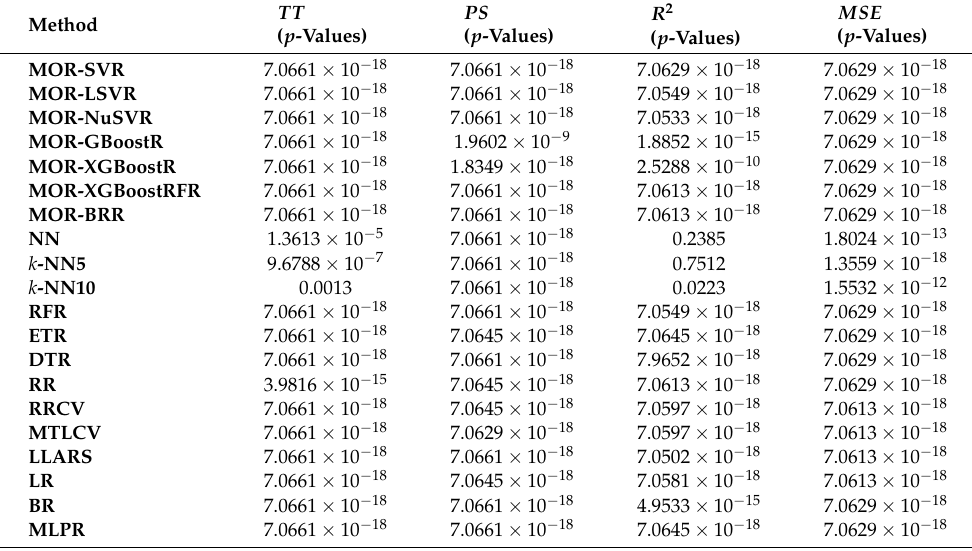
Table 15. Hypothesis test: k -NN20 v other methods (the second